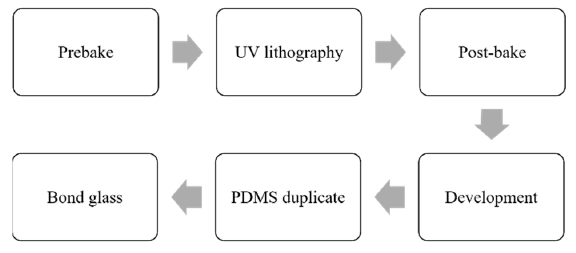
Figure 3. Fabrication process of the microfluidic chip.